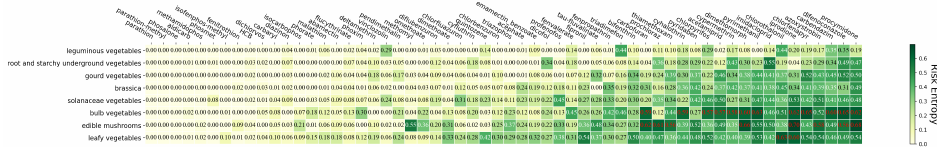
Figure 9. Heat map of the risk entropy of ‘Categoriy + Indicator’, the row labels are the names of 8 agricultural categories and the columns are labelled with 58 indicators of pesticide residue detection. Darker colours indicate higher values of the risk entropy.